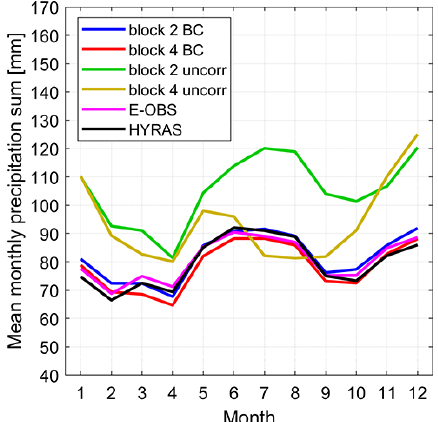
Figure 4. Annual cycle of the spatially averaged mean monthly pre- cipitation sum [in mm] based on LAERTES-EU data block 2 and 4 for uncorrected model data (uncorr), bias-corrected data (BC), E- OBS, and